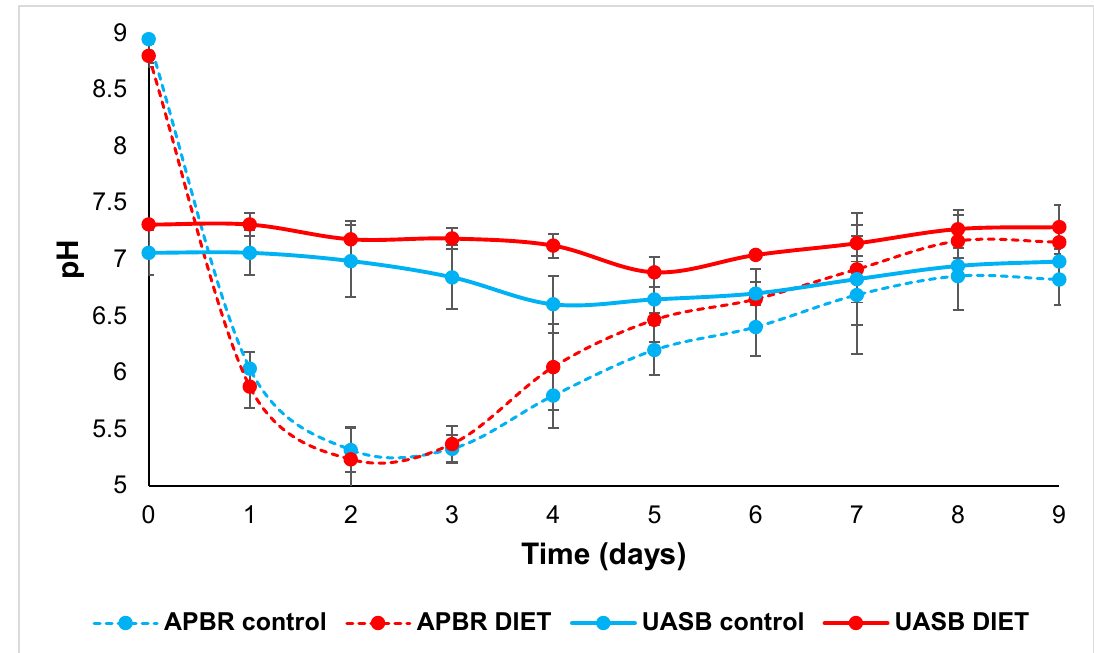
Figure 4. pH in APBR control, APBR DIET, UASB control and UASB DIET.